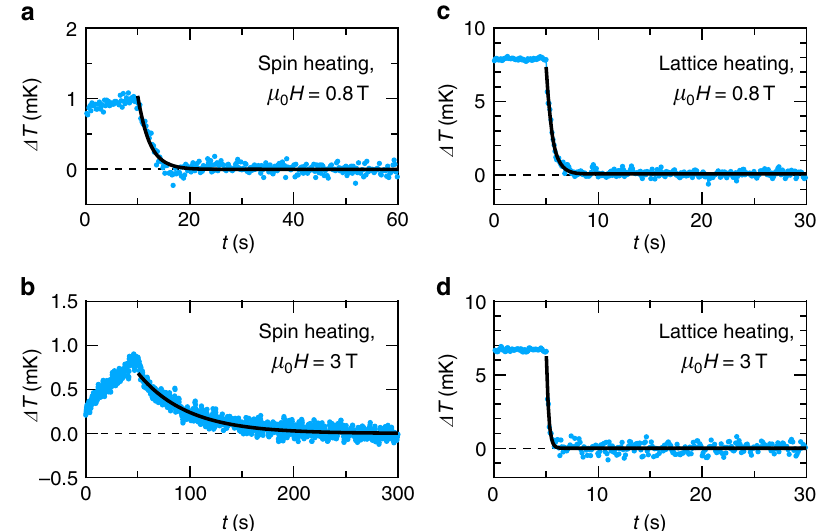
Fig. 1 Thermal relaxation curve at the temperature of 0.26K. Thermal relaxation curve for the spin (magnetocaloric) heating, when the magnetic fi eld is swept up from a 0.6 to 0.8 T, and b 2 to 3 T. The thermal relaxation curve for the lattice (Joule) heating at c μ 0 H = 0.8 T and d 3 T. In each fi gure, the solid line represents a single exponential decay, Δ T = A exp( − t / τ ), with the relaxation time, τ , and a constant,